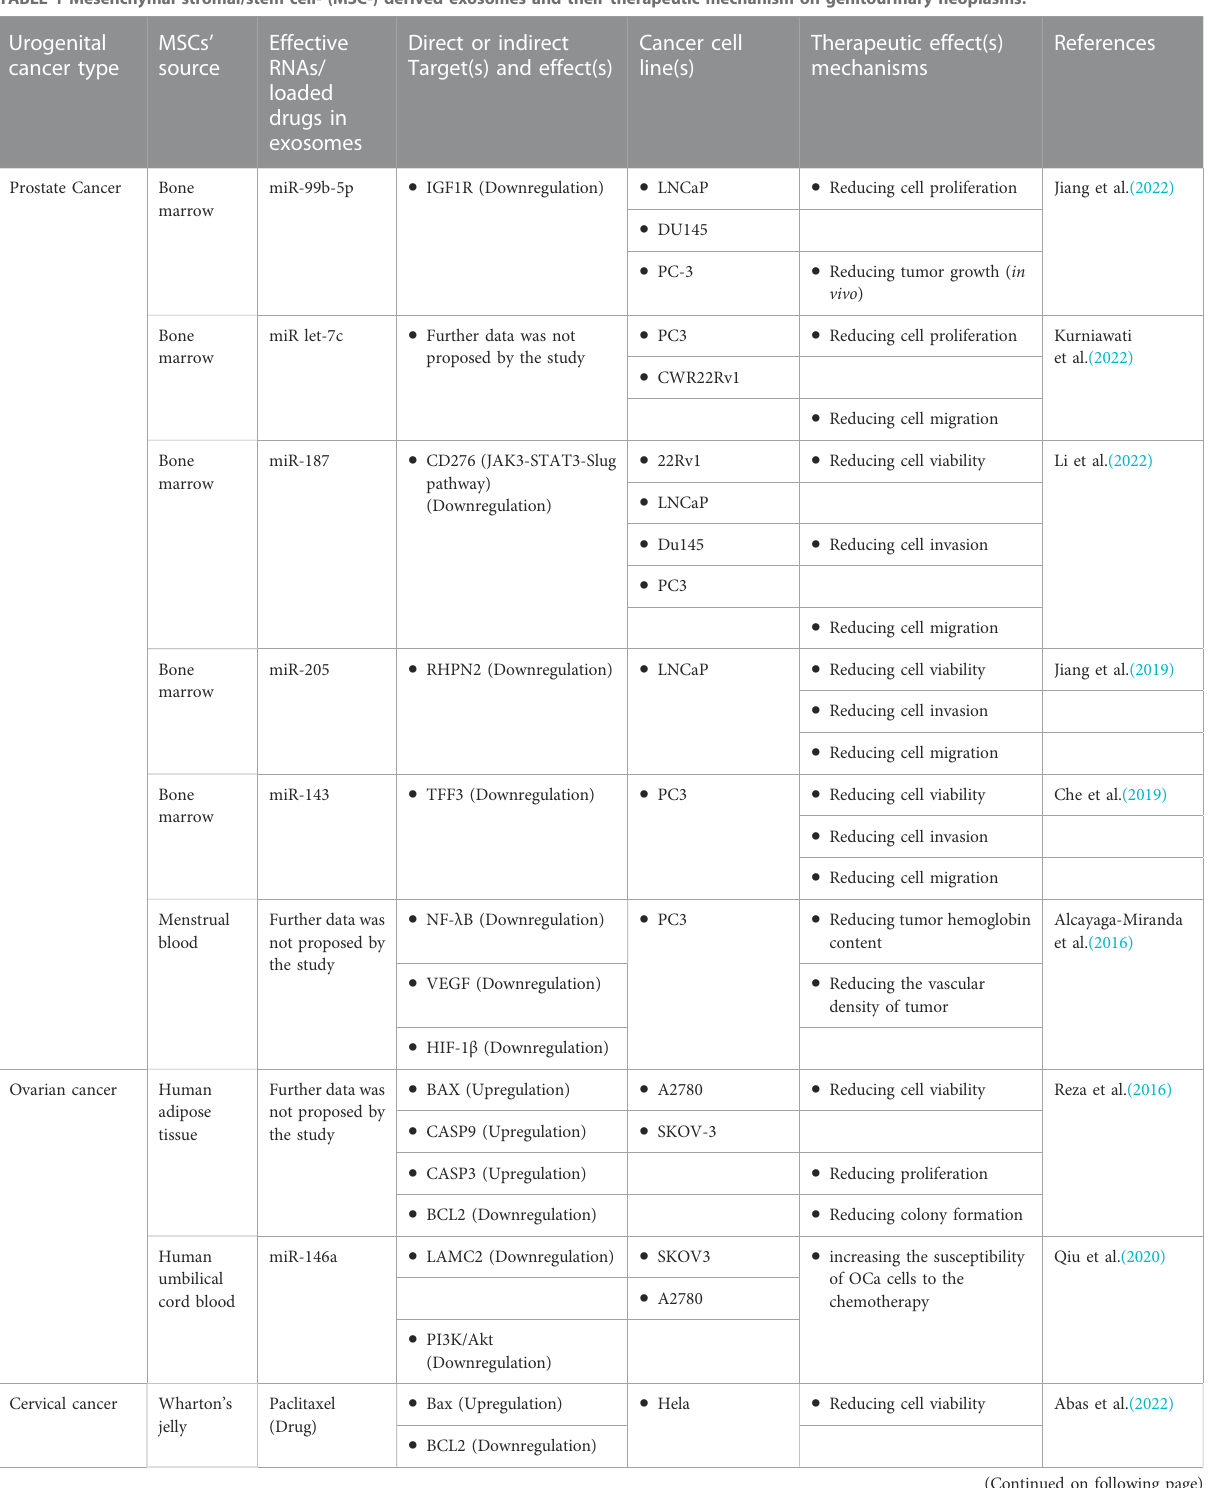
TABLE 1 Mesenchymal stromal/stem cell- (MSC-) derived exosomes and their therapeutic mechanism on genitourinary